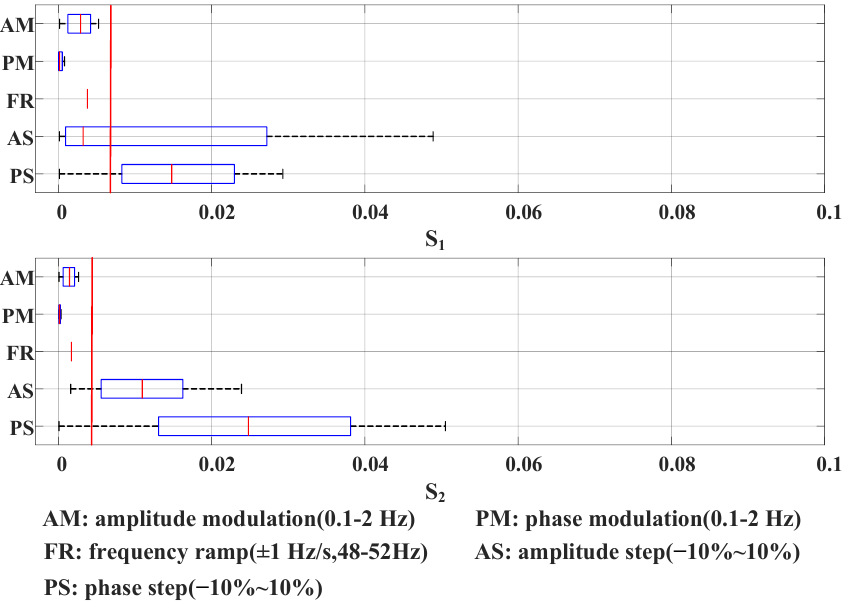
Figure 5. Boxplot representation of S1 ( top ) and S2 ( bottom ) in all dynamic events.